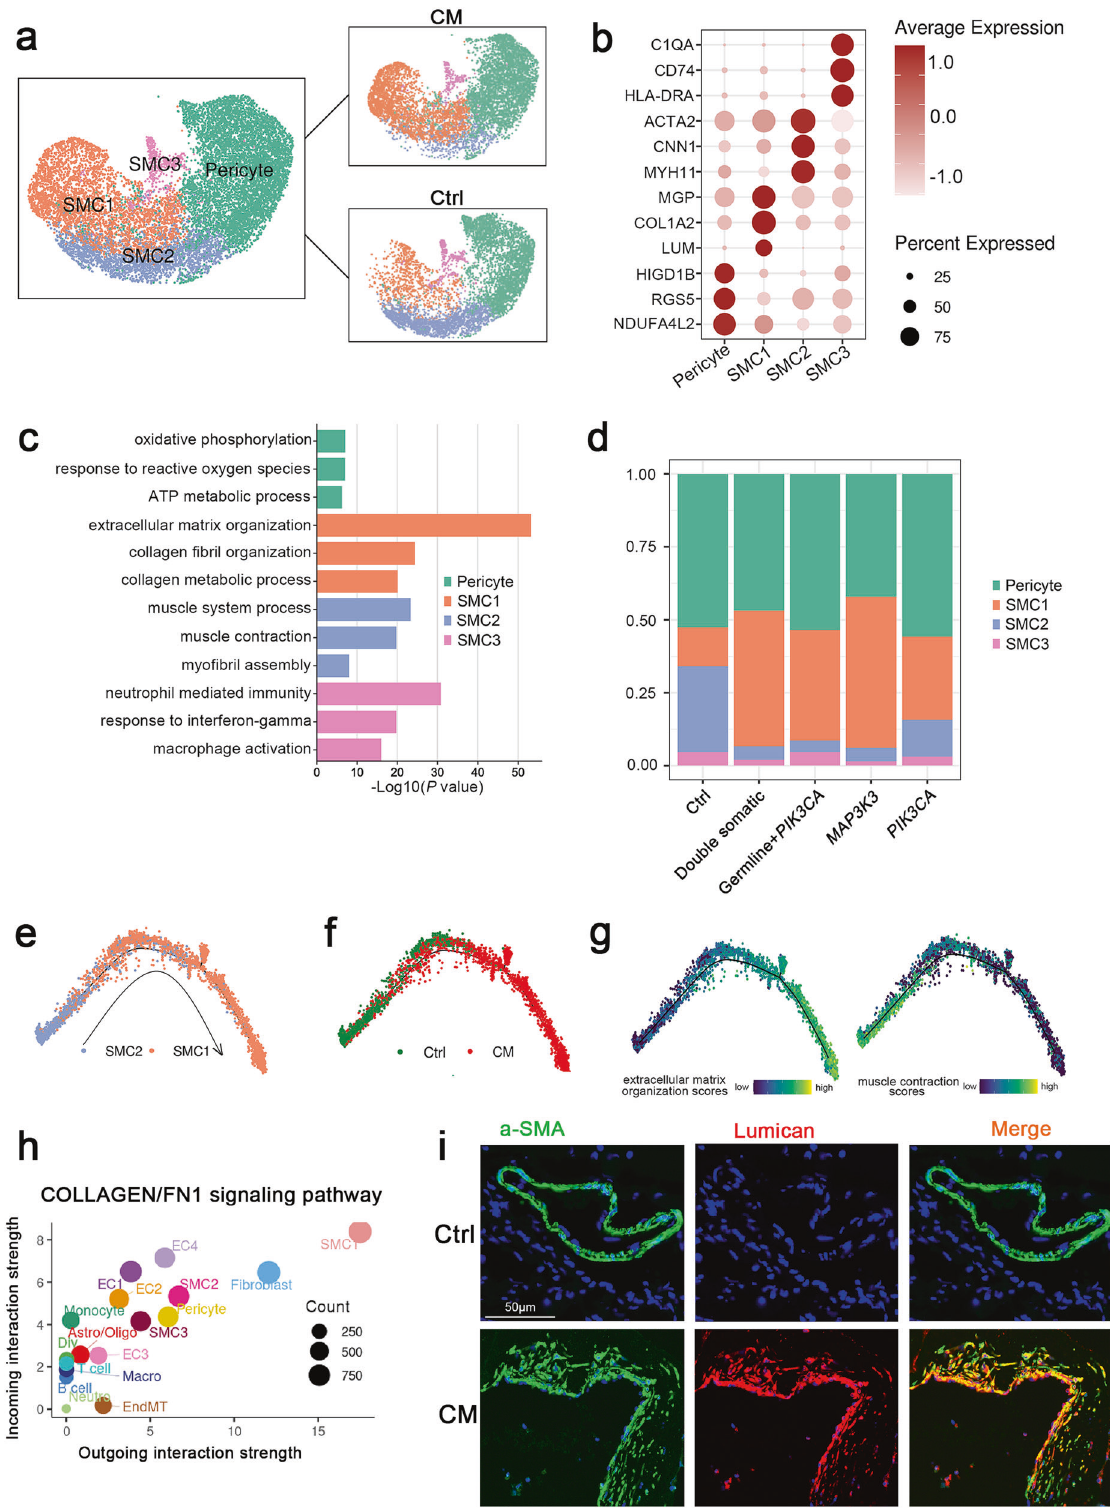
Fig. 6 Mural cell clusters. a UMAP plot for the distributions of four mural cell subclusters (left panel) divided by control and CM groups (right panel). b Marker genes of four mural cell subclusters. c GO enrichment analysis of DEGs in four mural cell subclusters. d The proportions of the four mural cell subclusters in the different groups. Monocle 2 pseudotime analysis for SMC1 and SMC2 marked with cell types ( e ), control and CMs groups ( f ). g Extracellular matrix organization and muscle contraction scores along the pseudotime axis. Speci fi c genes are shown in Supplementary Table 4. h Scatter plot showing outgoing ( x -axis) and incoming ( y -axis) cellular interaction strength of COLLAGEN and FN1 signaling pathways in all cell types. i Immuno fl uorescence staining of SMC1 marked by a-SMA and lumican in ( b ) in the control and CM groups. Lumican, red; a-SMA, green and DAPI-stained nuclei shown in blue. Scale bars, 50